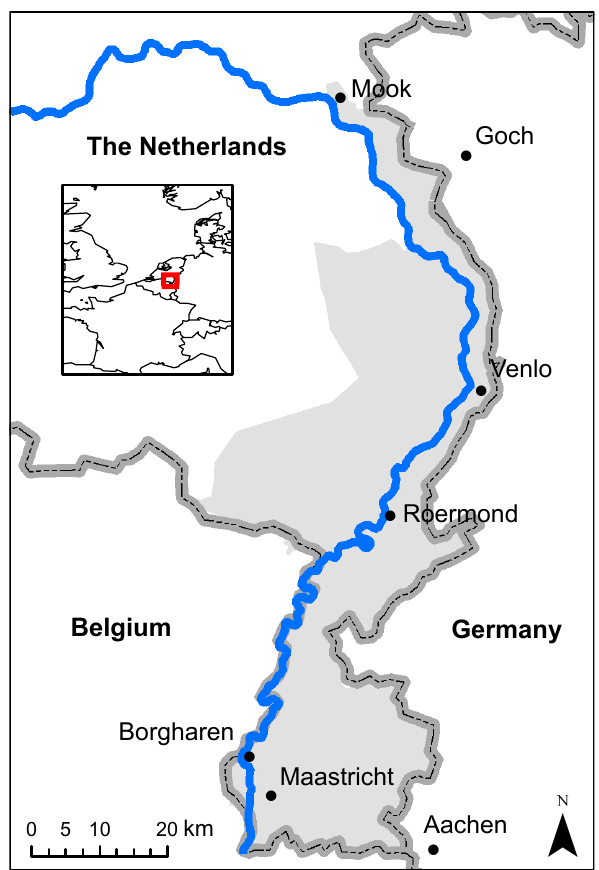
Fig. 1. Map showing the location of the study area. Dutch Limburg is shown in grey: the river Meuse enters The Netherlands in the south from Belgium and drains into the North Sea to the west of